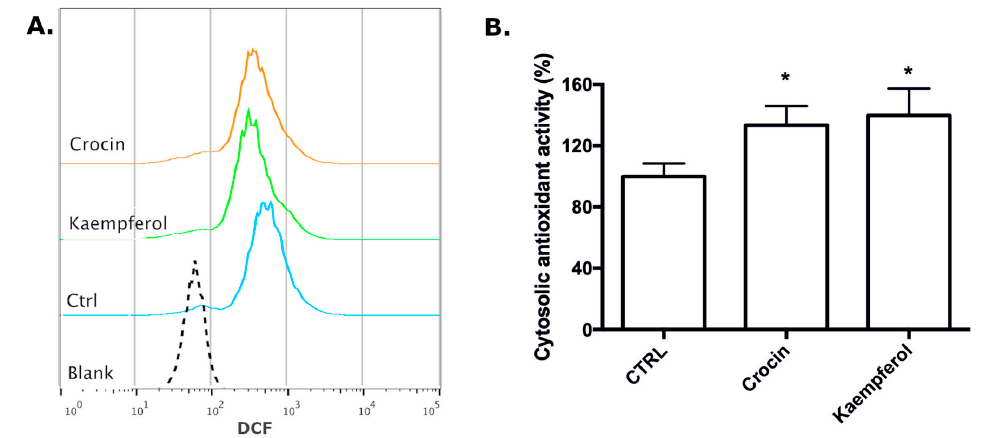
Figure 8. Effect of crocin and kaempferol on ROS production at single cell level and total antioxidant activity of H9c2 cells. H9c2 cells were treated with 5 μ M of the crocin or kaempferol for 1 h. ( A ) Intracellular ROS were evaluated at single cell level using DCFH-DA by flow cytometry as reported in Materials and Methods. ( B ) Total antioxidant activity was measured as reported in the Materials and Methods and expressed as percent of control cells. Each bar represents means ± SE of three independent experiments ( n = 3). Data were analyzed with one-way ANOVA followed by the Bonferroni’s test. * p < 0.05 vs.